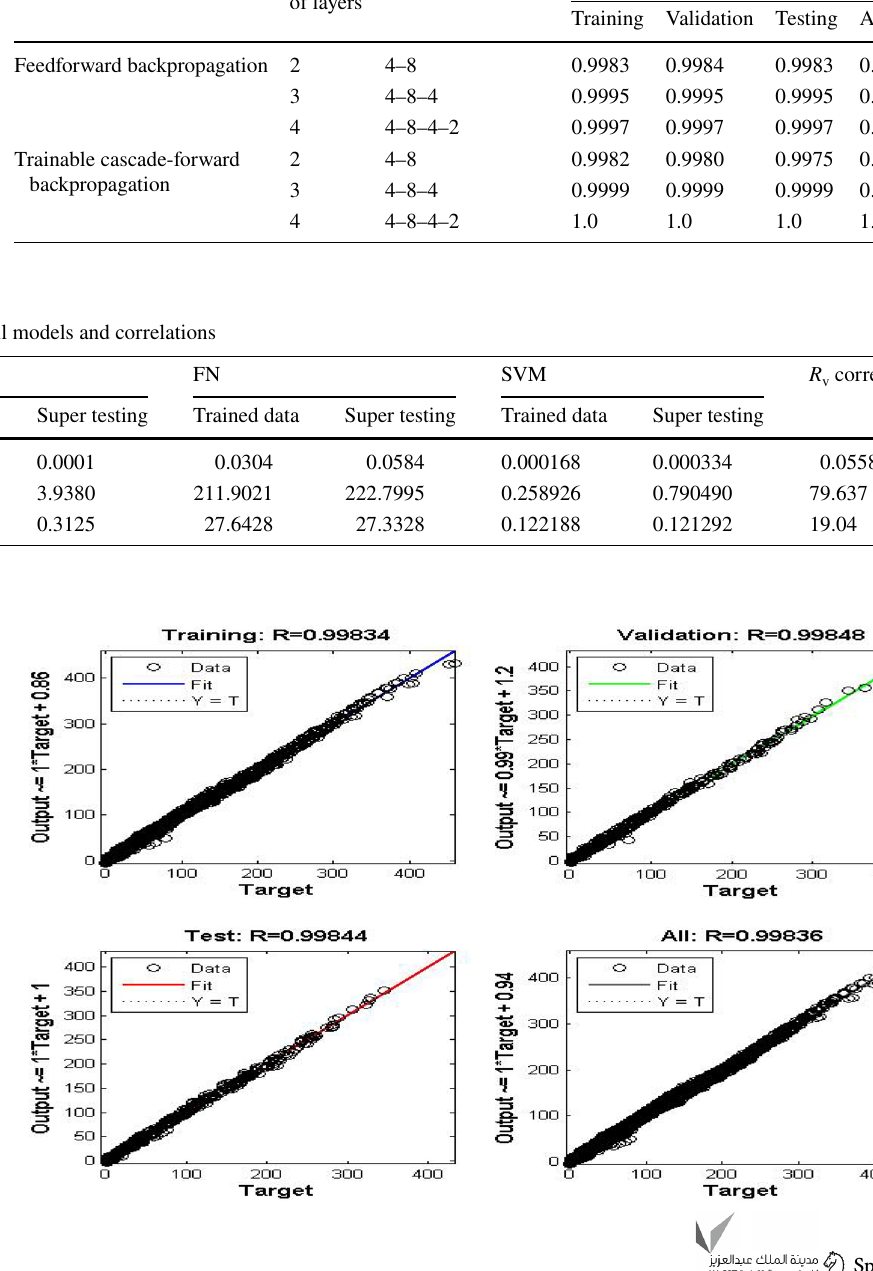
Table 3 Neural network results